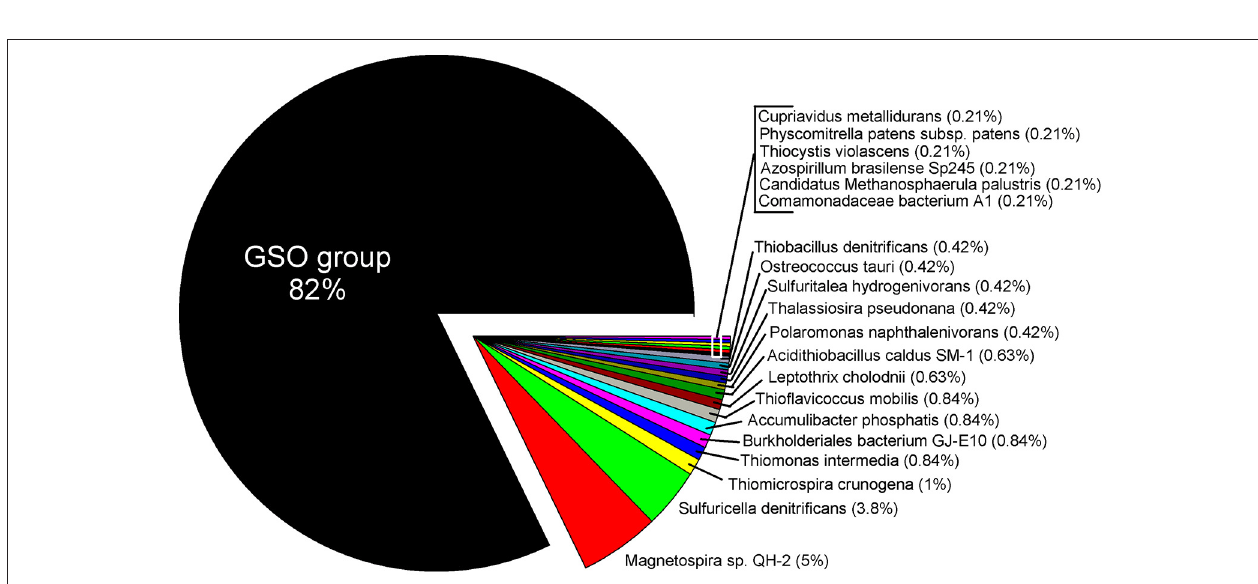
FIGURE 9 | Taxonomic assignation of the expressed sequences for RuBisCO at 85m during upwelling (March 2011). The taxonomy was based in the KEGG Orthology (KO) database and shows a clear dominance of transcripts associated to the GSO group. same pattern of expression, but with a slightly higher